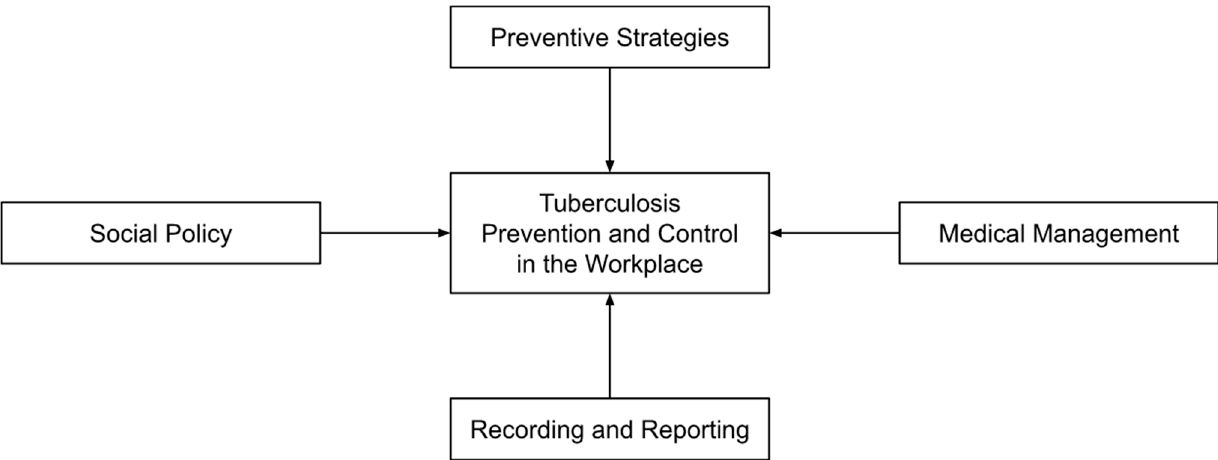
Figure 1. Framework for assessment of Tuberculosis Prevention and Control in the Workplace policy [10].